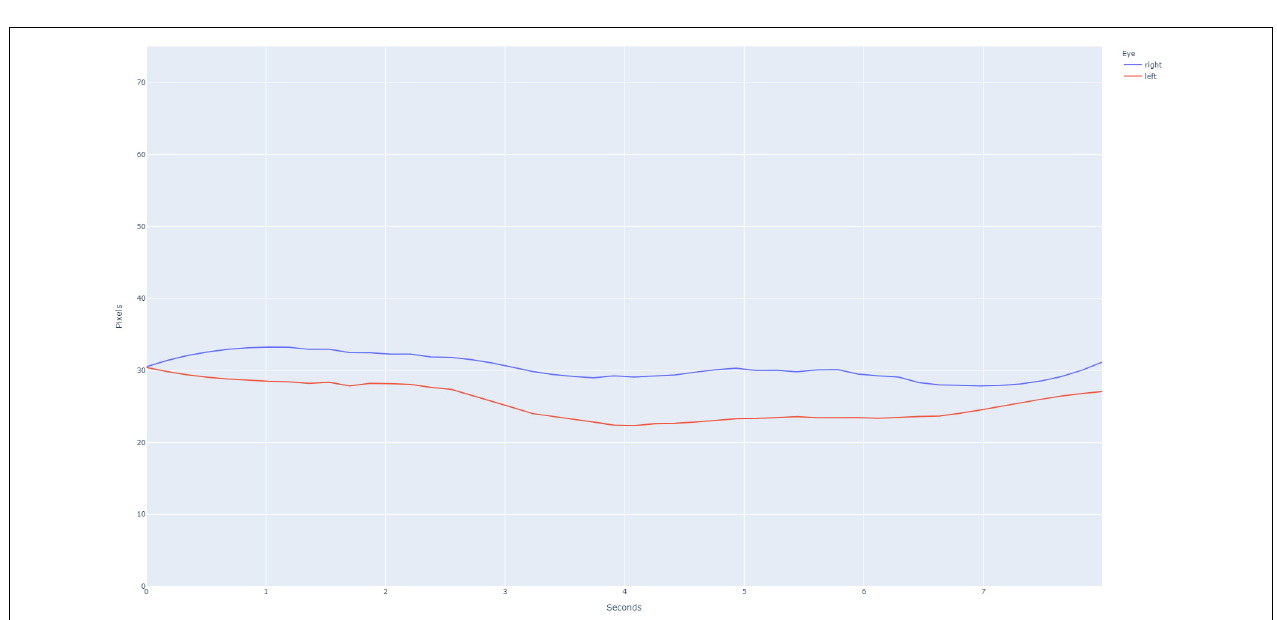
FIGURE 3 | Example pupillary light reflex (PLR) curve for an abnormal subject, as is evidenced by the lack of constriction after light stimulus is applied at the 3 s time point. The PLR curves for the right eye (blue) and left eye (red) are presented.